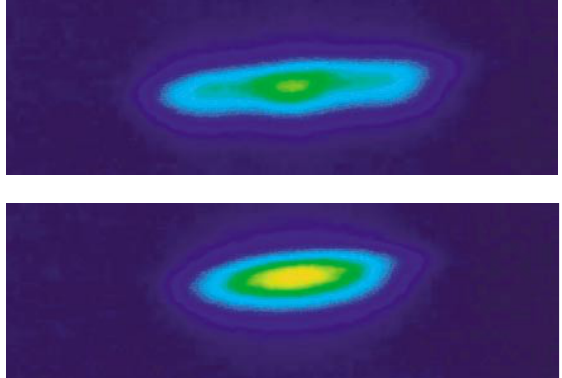
FIG. 3. (Color) The images of synchrotron light monitor with (top panel) and without (bottom panel) rf voltage